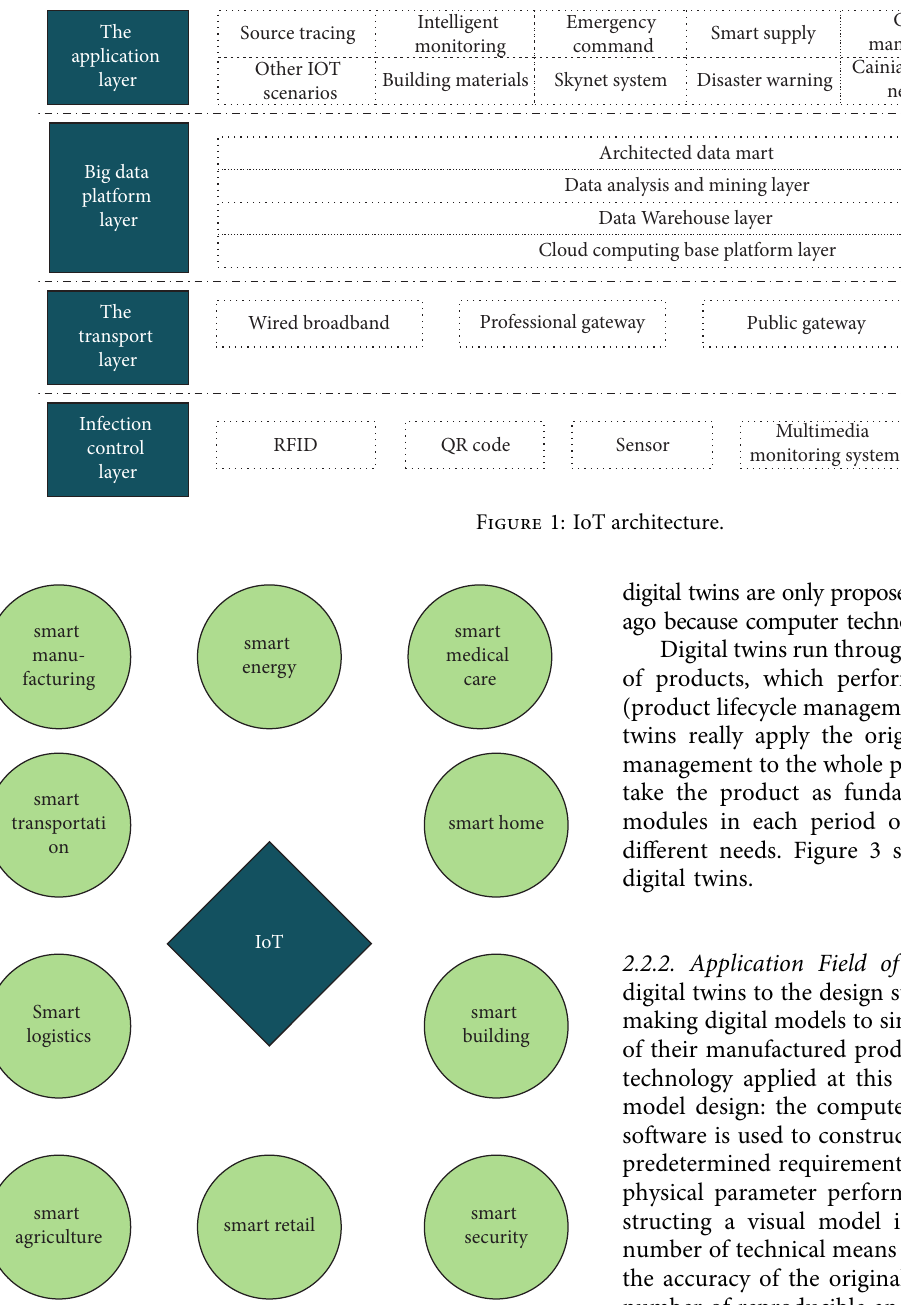
Figure 2: Application fields of